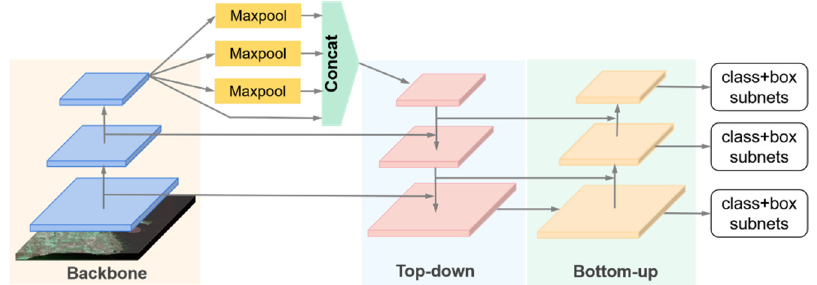
Figure 11. The general architecture of